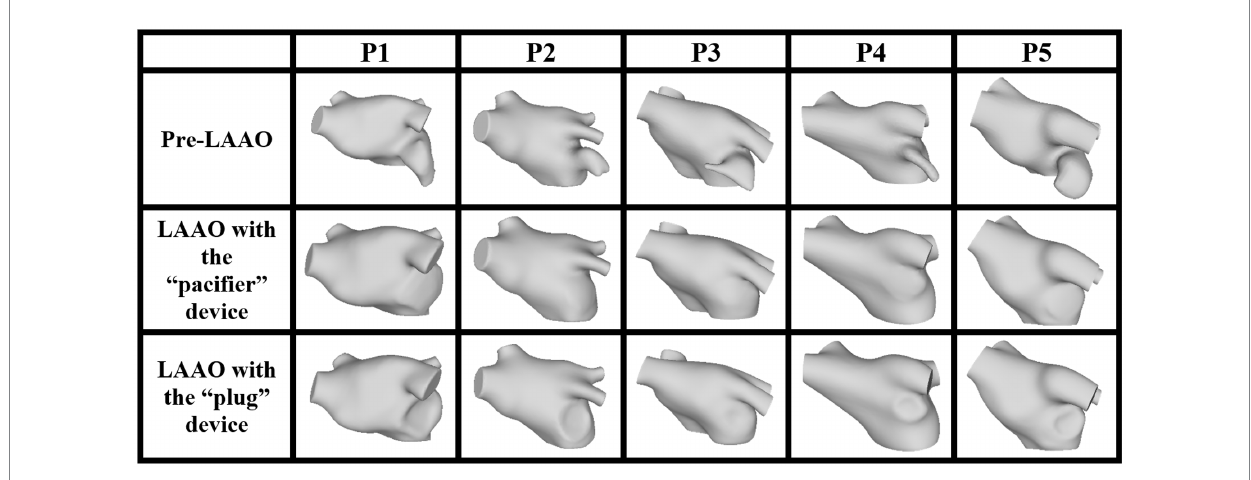
FIGURE 1 LA anatomical model, pre- (first row) and post-occlusion applying the devices based on the pacifier principle (second row) and on the plug principle (third row).